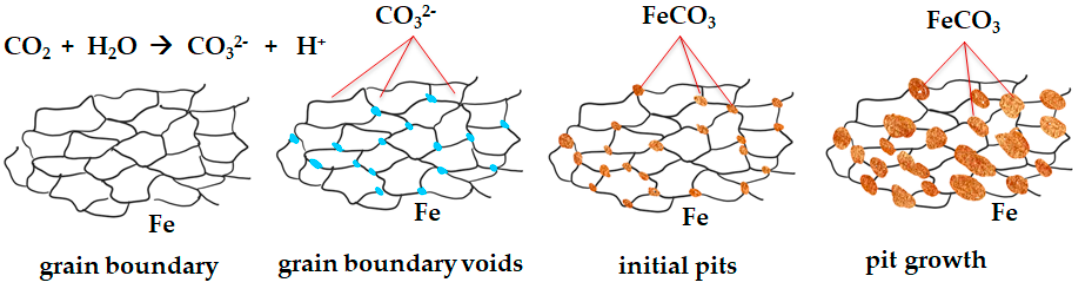
Figure 10. Schematic drawing of pit precipitation on injection steels initiated at grain